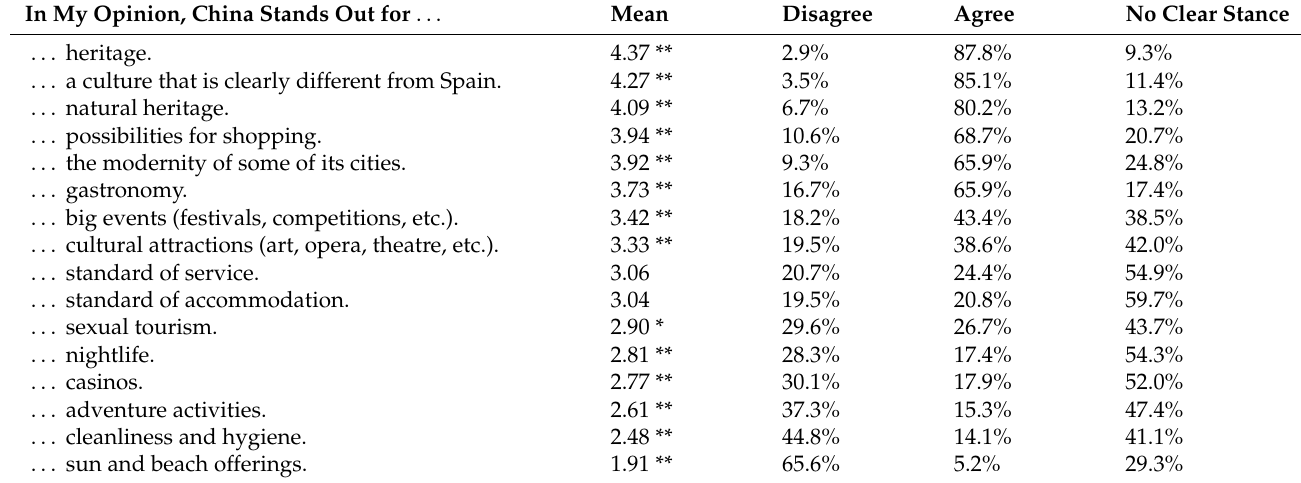
Table 4. China stands out for . . .